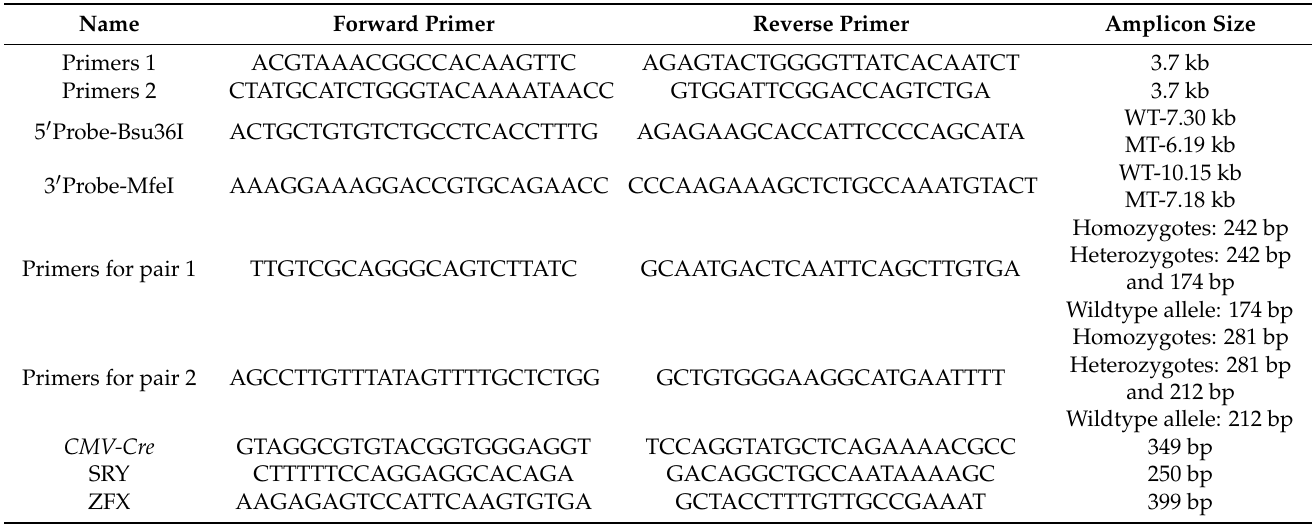
Table 2. Sequences of primes and probes used in this